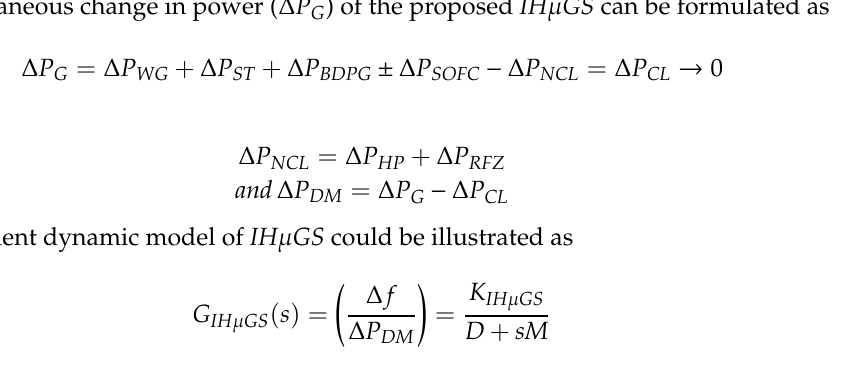
Refer to Table 1 for the nomenclature and abbreviations used for IH µ GS system